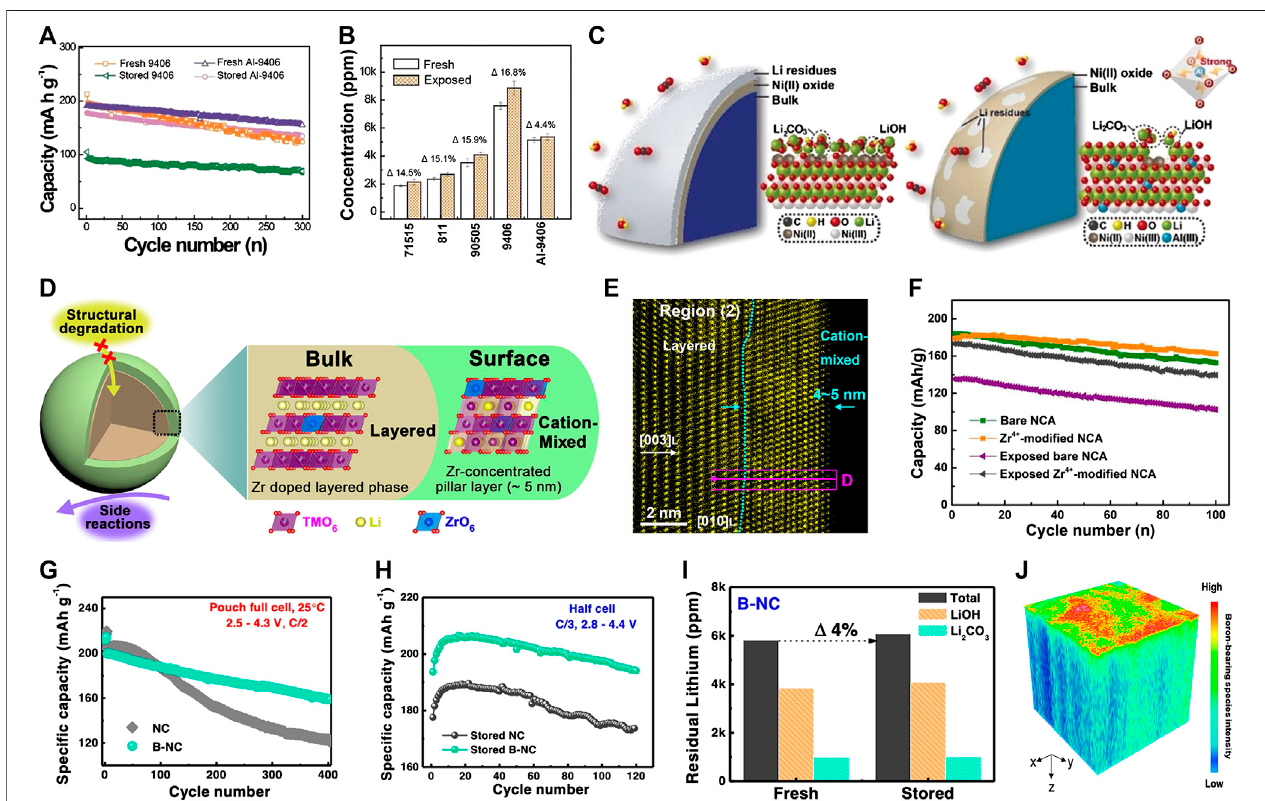
FIGURE 6 | (A) Cycling performance curves of pristine and Al doping modi fi ed material before and after air storage for 30 days and (B) Concentration of residual lithium species on Ni-rich cathode with various Ni contents before and after air exposure for 30 days and (C) Schematic illustration of the mechanism of Al-doping in improving air stability of Ni-rich cathode. Adapted from [You et al., 2018] with permission from Wiley-VCH Verlag GmbH &Co. KGaA, Weinheim. (D) Schematic view of the surface structure of Zr doped Ni-rich cathode with its functions during cycling and (E) HAADF − STEM image as an evidence of the formation of cation mixed layer. Adapted from [Han et al., 2018] with permission from American Chemical Society. (F) Cycling performances of both bare and Zr 4+ modi fi ed NCA before and after air exposure, indicating enhanced cycling stability and air stability of Zr doped NCA. Adapted from [Lai et al., 2019] with permission from Elsevier. (G) Cycling performance comparison of LiNi 0.94 Co 0.06 O 2 before and after B 2 O 3 doping in pouch full cell with graphite anode cycled between 2.5 and 4.3 V at 25 ° C and (H) Cycling performancecomparison ofthe30-daystoredLiNi 0.94 Co 0.06 O 2 beforeandafterB 2 O 3 dopinginhalfcelland (I) Residuallithiumcontentchangesofthefreshand30-day air-storedB 2 O 3 dopedLiNi 0.94 Co 0.06 O 2 and (J) TOF-SIMSthreedimensiondepthpro fi lingofBo x − ( x (cid:1) 1or2)speciesinthefreshB 2 O 3